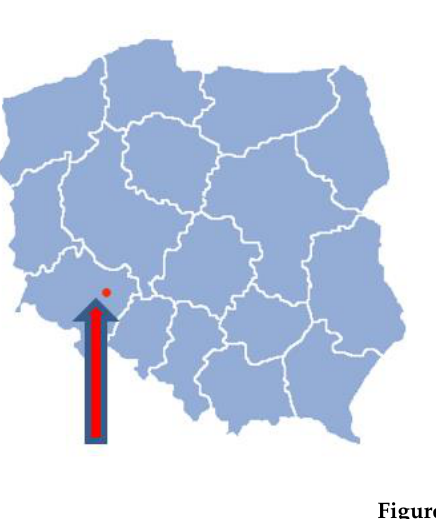
Figure 1. Location of experiment.